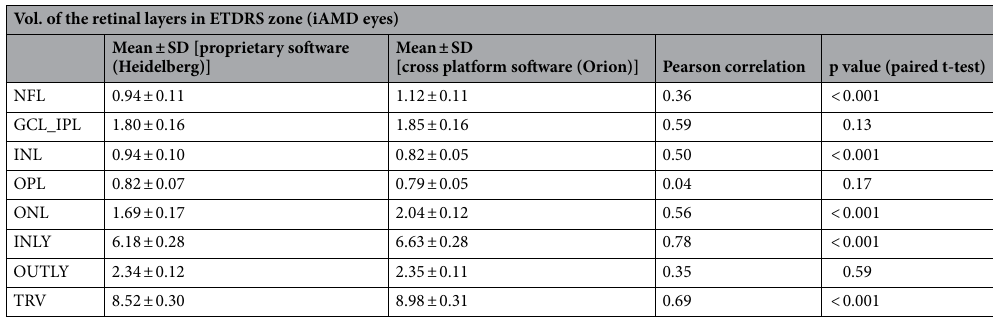
Table 4. Layer volume data in eyes with iAMD from the proprietary and the cross-platform